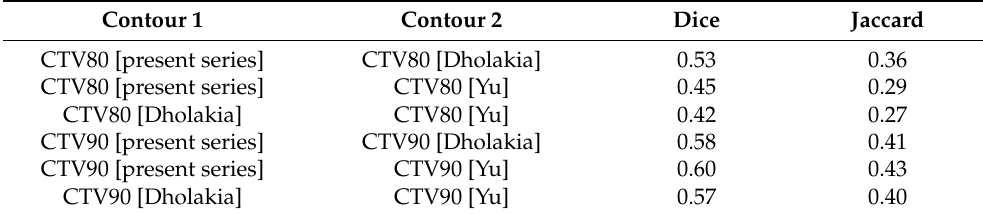
Table 2. Similar coefficients between CTV80 and CTV90 calculated by Yu et al. [23] and Dholakia et al. [24], respectively, and the corresponding CTVs extracted as iso-level recurrence probability in the present series.